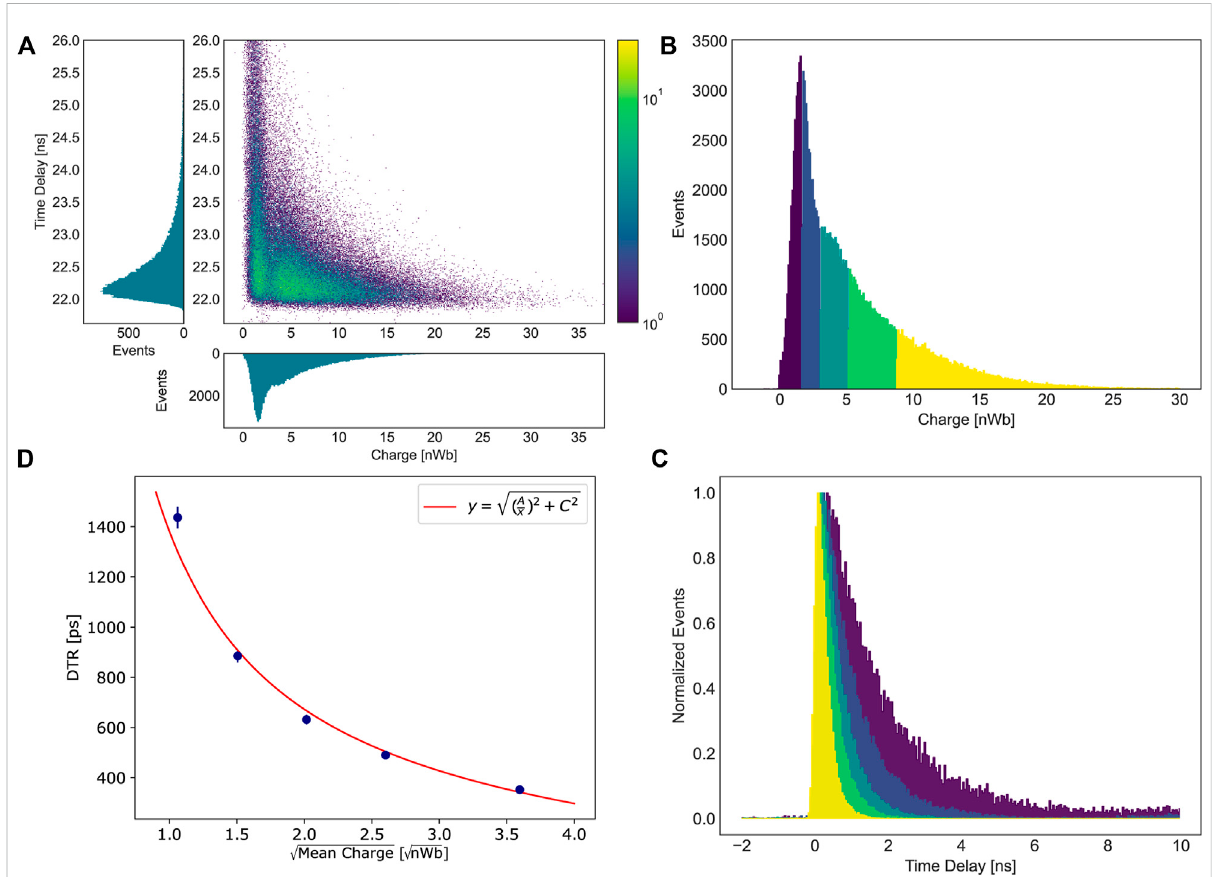
FIGURE 6 Correlation between time resolution (DTR) and deposited energy (mean integrated charge) for LSO. 2D histogram of time delay versus integrated charge (A) . The charge distribution of LSO has been divided into fi ve intervals containing about the same number of events (B) ; for each interval,themeanchargewasevaluated,andthetime delaydistributionwasconsidered (C) .TheDTRwasevaluatedastheFWHM ofthedistribution. Finally the DTR was plotted as function of the square root of the mean charge and fi tted with y (cid:2)